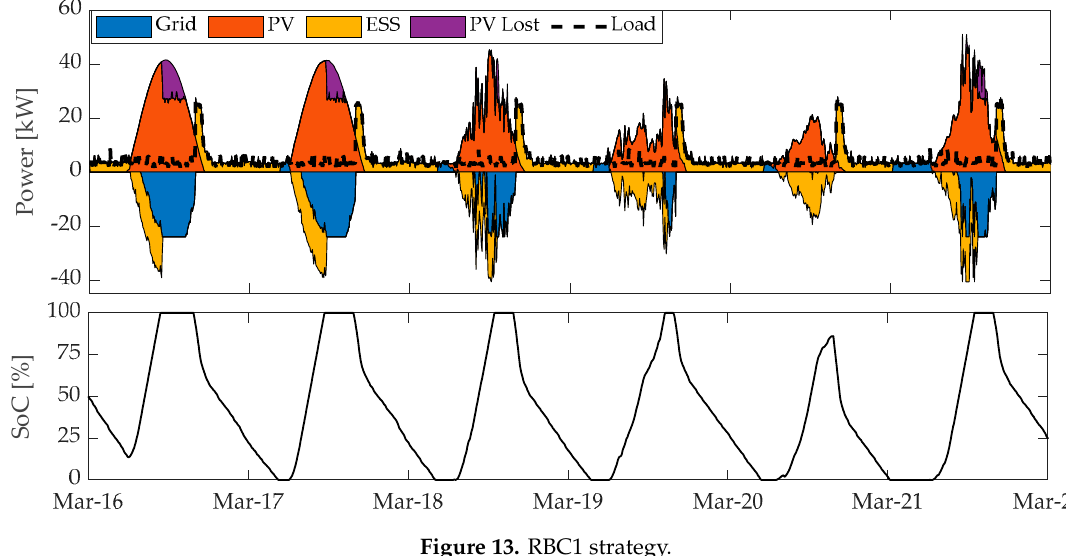
Figure 13. RBC1 strategy.